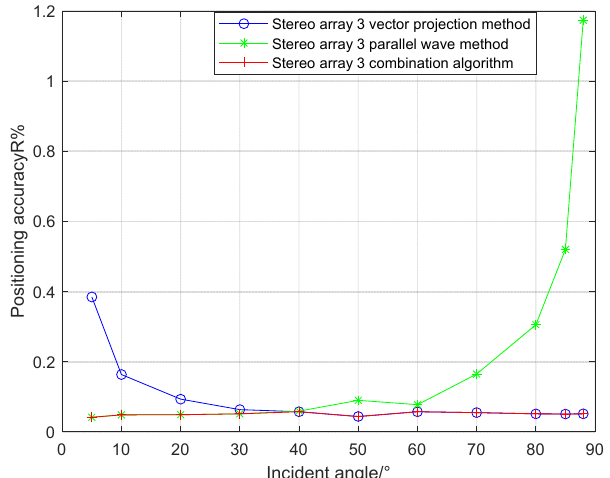
Figure 22. Comparison of three stereo arrays under combination algorithm. The localization efficiency in terms of localization time was evaluated and compared with other related methods, i.e., the algorithm in literature 18, the orthogonal 8-element array, the non-equidistant quaternary array and the orthogonal quaternary array. The localization processing time is illustrated in Table 1. Table 1. The localization processing time. Array